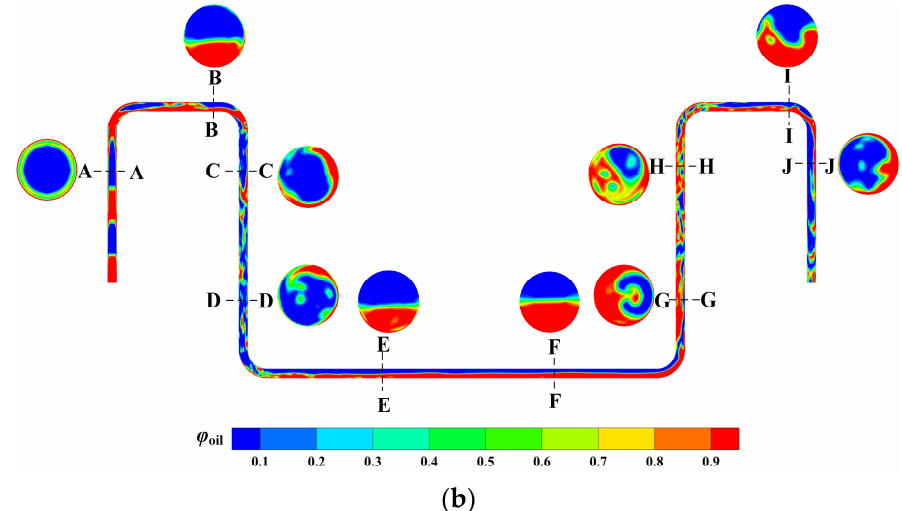
Figure 6. Flow evolution in the static jumper in case 1, where φ gas is the gas void fraction, t is the flow time, and A-A, B-B, C-C, D-D, E-E, F-F, G-G, H-H, I-I and J-J denote the selected cross-sections along the jumper: ( a ) the process of oil-gas mixture transported through the jumper; ( b ) contours of oil volume fraction in considered cross-sections when the periodically stable flow is achieved in the jumper.